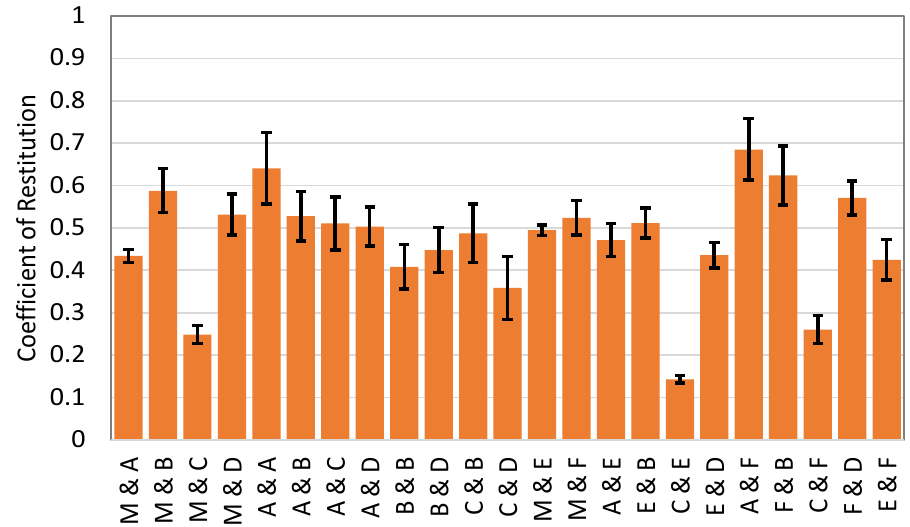
Figure 8. Coe ffi cient of restitution: Average value and standard deviation. M stands for Figure 8. Coefficient of restitution: Average value and standard deviation. M stands for manipulator.